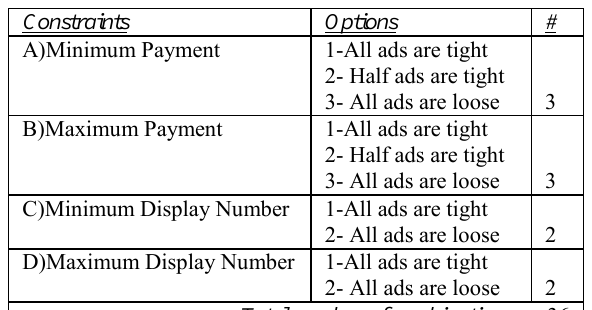
Table 1. The conditions for each constraint used during the experimental